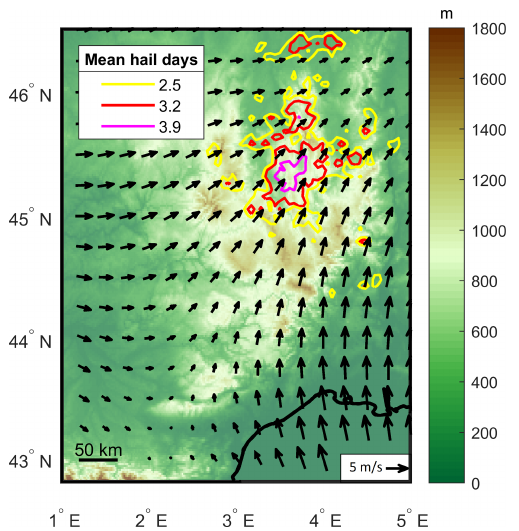
Figure 4. Contours of the average number of hail days per year from 2005 to 2014 overlaid with the orography and the 10m mean wind flow during hail